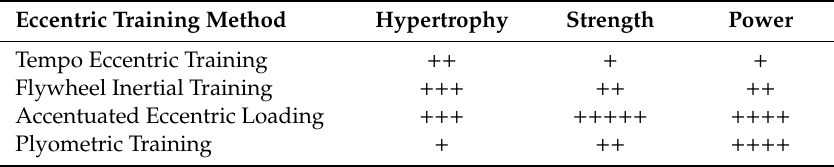
Table 2. The theoretical potential of eccentric training methods to benefit hypertrophy, strength, and power output. Eccentric Training Method Hypertrophy Strength Power Tempo Eccentric Training ++ + Flywheel Inertial Training +++ ++ ++ Accentuated Eccentric Loading +++ +++++ ++++ Plyometric